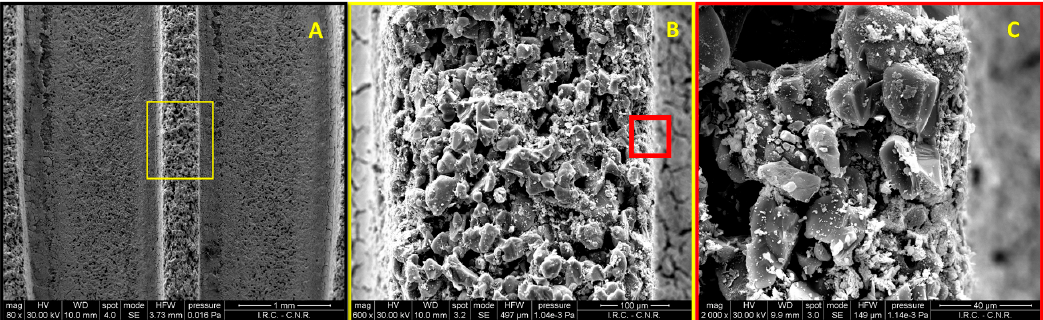
Figure 2. SEM images of 10 Ni monolith. ( A ) 80× enlargement; ( B ) 600× enlargement of the yellow box reported in Figure A; ( C ): 2000× enlargement of the red box reported in figure B.